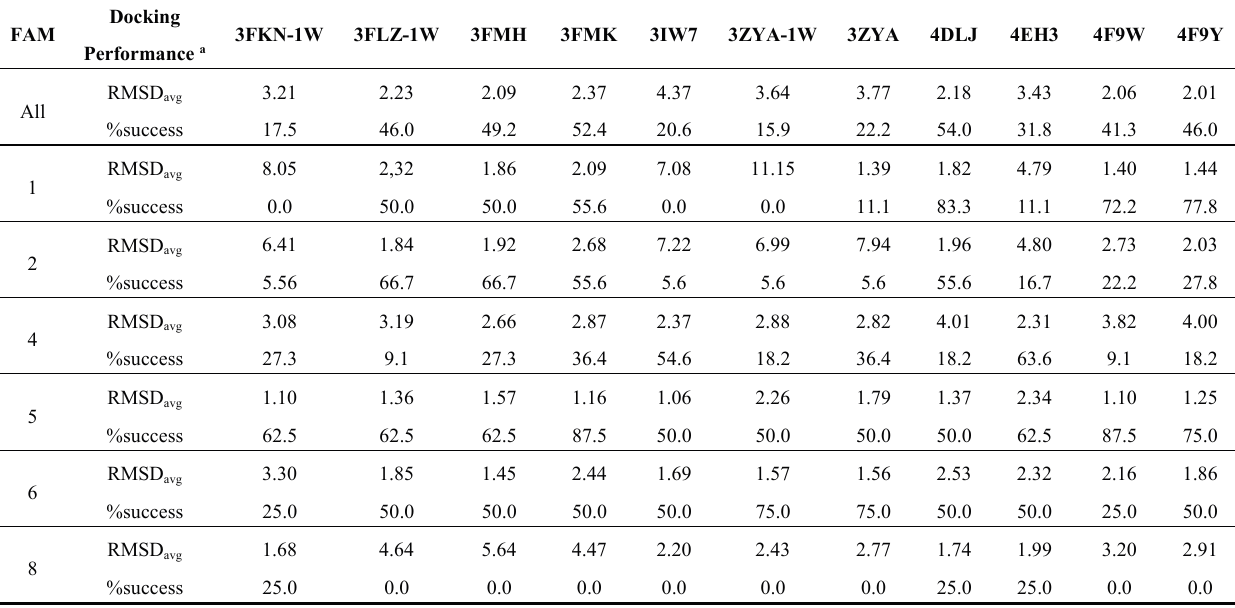
a RMSD avg (expressed in Å) is the average RMSD calculated for the seven sets of ligands. The corresponding success rate (% success) in correctly predicting crystal ligand conformations ( i.e. , RMSD values ≤ 2 Å) is also